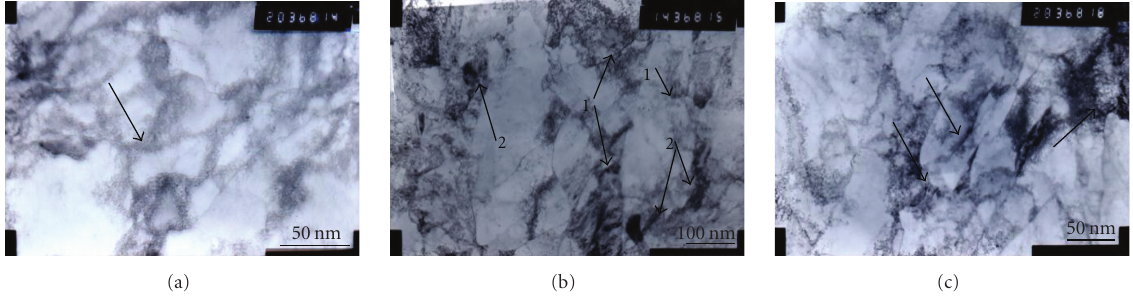
Figure 7: TEM pictures of grade X100 pipelines microstructure after plastic deformation.